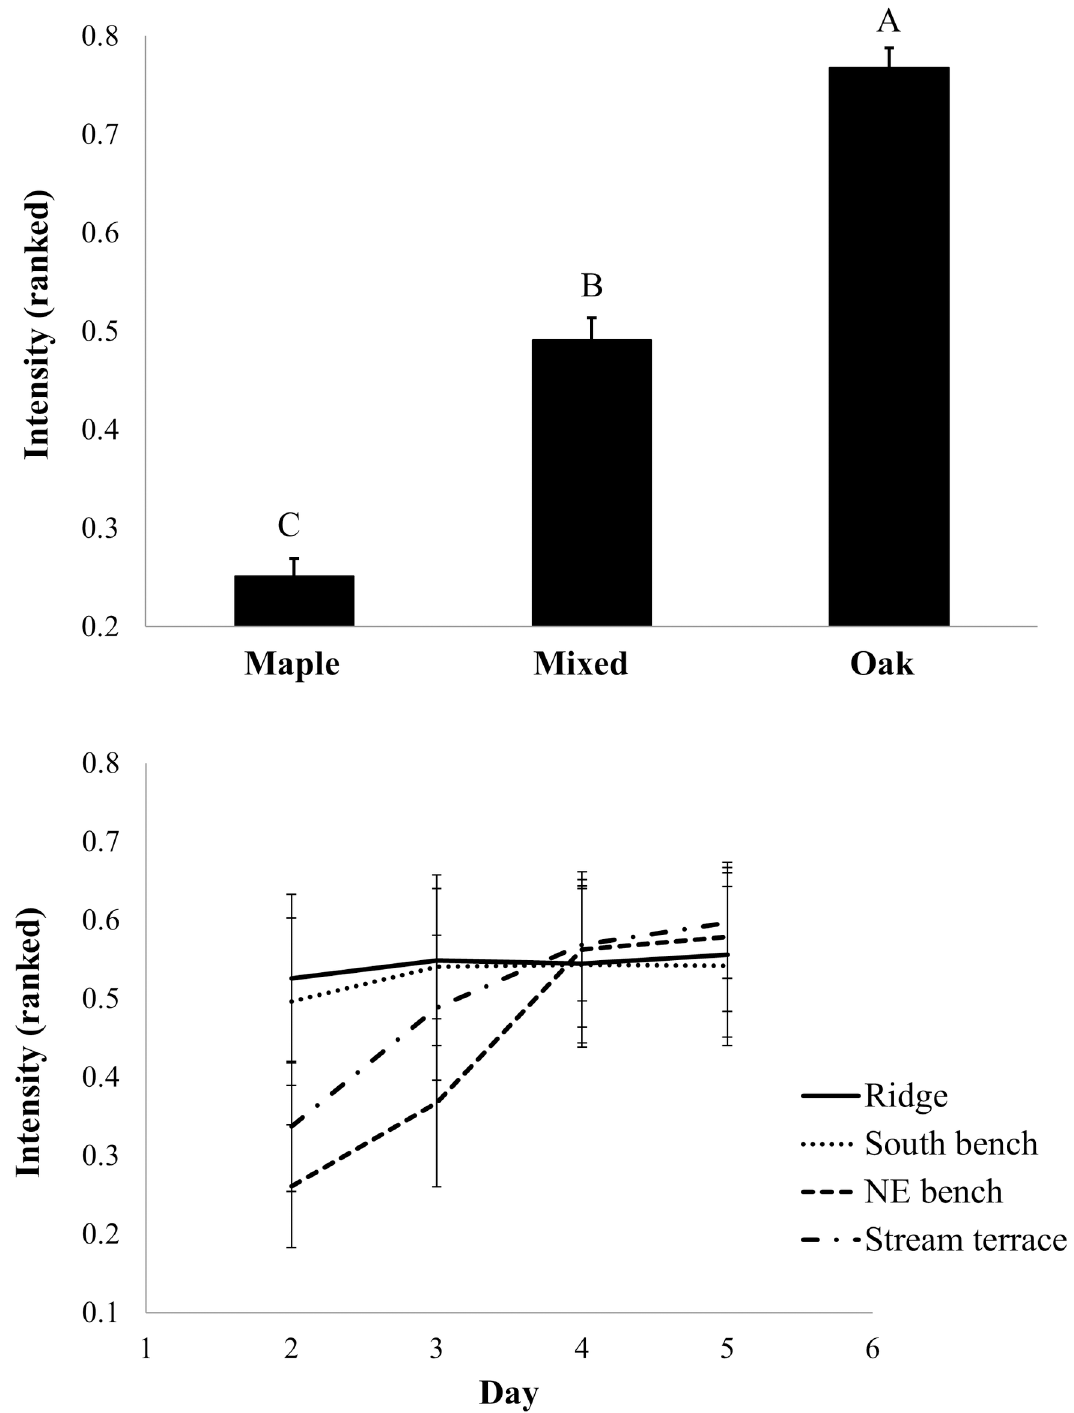
Fig 11. Modeled fireline intensity for common garden fuel beds. Ranked fireline intensity is shown as a function of litter source, topographic position, and day during the dry-down. Fireline intensity was calculated from [52] for common garden fuel beds based on measured fuel bed, fuel particle, and combustion characteristics. Standard errors are